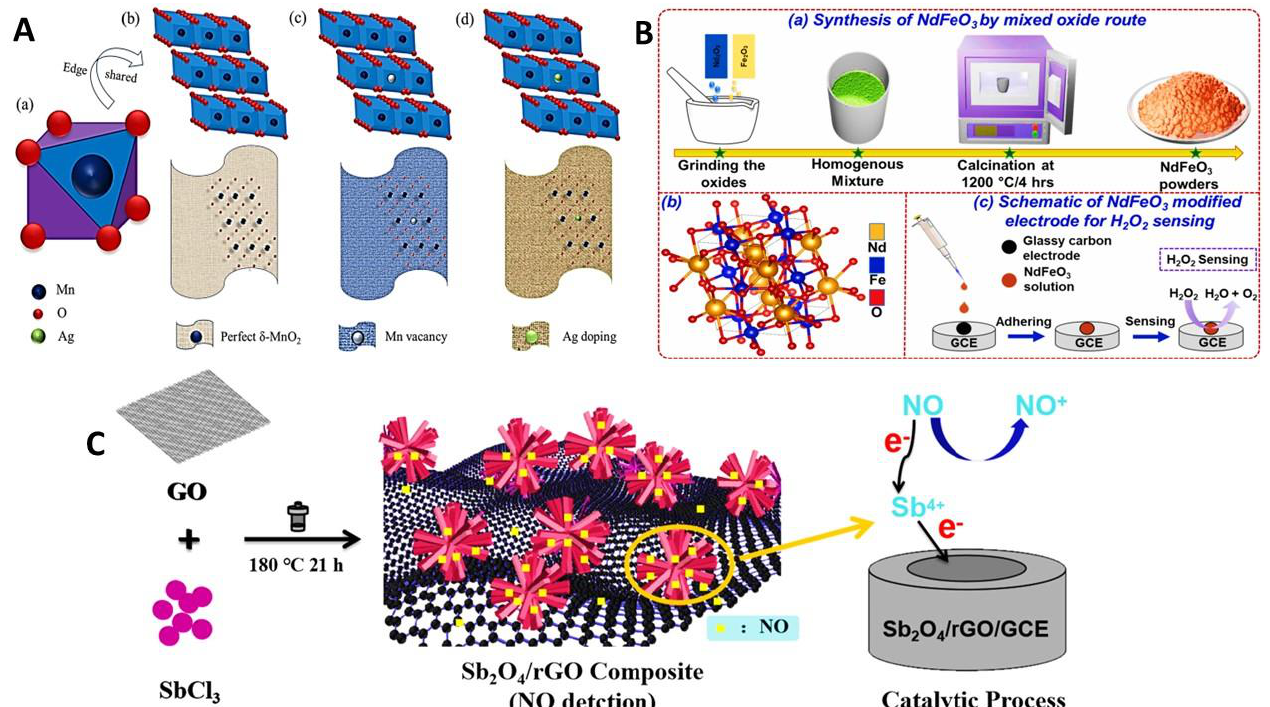
Figure 3. ( A ) Schematic representation of the [MnO 6 ] octahedral unit ’ s fundamental structure ( a ), perfectly aligned [MnO 2 ] nanorods ( b ), Mn vacancies in [MnO 2 ] nanorods ( c ), and Ag doping in [MnO 2 ] nanorods ( d ). Reprinted with permission from [79]. ( B ) NdFeO 3 fabrication using a mixed oxide method in ( a ), and its molecular structure, and ( b ) modified NdFeO 3 electrodes can be used to detect H 2 O 2 , (c) GCE modification for the detection of H 2 O 2 , Reprinted with permission from [87]. ( C ) Schematic of Sb 2 O 4 nanoflowers grown on RGO and EC detection of NO. Reprinted with permission from